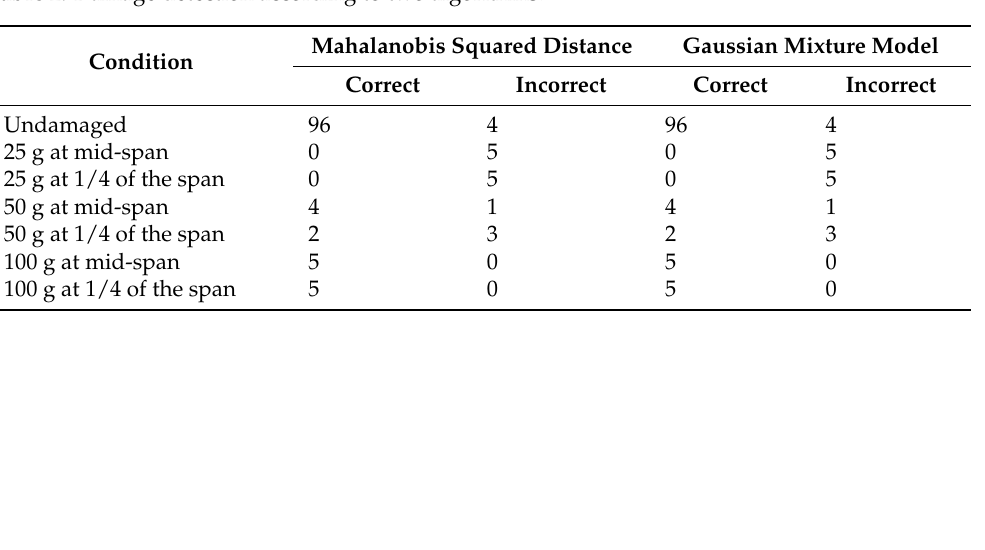
Table 2. Damage detection according to two